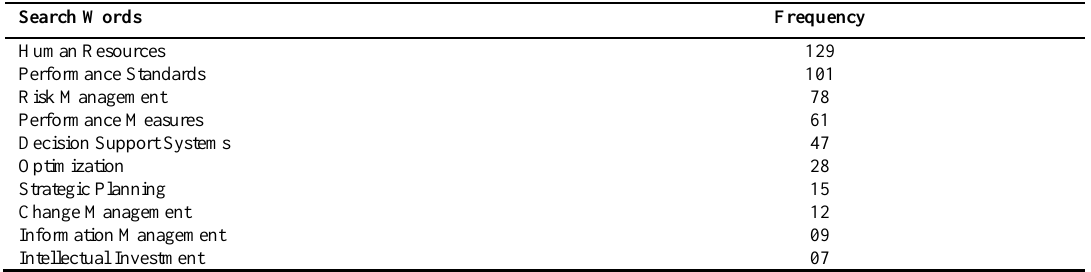
Table 10. Top 10 commonly search words: intellectual capital and operational